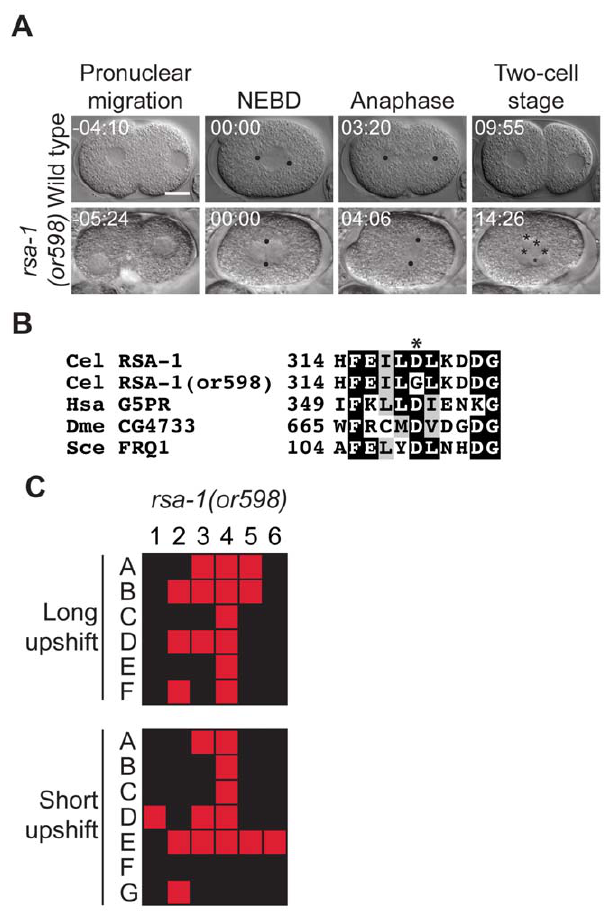
Figure 3. An rsa-1 mutant. A. DIC time-lapse images of wild-type and rsa-1(or598 ts ) embryos. In the rsa-1 mutant the nuclear centrosomal complex (NCC) failed to rotate and a small transverse P 0 spindle assembled, cytokinesis failed, and multiple nuclei were present at the two cell equivilent stage. The rsa-1(or598 ts ) embryo was shifted to the restrictive temperature for , 1 min. prior to imaging. Black dots represent centrosomes/ spindle poles and asterisks denote multiple nuclei per cell at the two cell stage. Times in min:sec are given relative to NEBD. Scale bar, 10 m m. B. Amino acid alteration in the mutant. Asterisk indicates the changed residue. Homologous proteins are aligned below the C. elegans protein. C. Defect map for individual embryos observed during time-lapse recordings: embryos are listed on the left and phenotypes are listed on the top: 1; pronuclei meet prior to NEBD, 2; Nuclear centrosomal complex centration, 3; Nuclear centro- somal complex rotation, 4; spindle size, 5; successful cytokinesis, 6; one nucleus per cell at two cell stage. In the long upshifts, hermaphrodites were transferred to the restrictive temperature for 5–8 hours. In the short upshifts, embryos were harvested from hermaphrodites grown at 15 u C and immediately mounted on agar pads for imaging, which took , 1